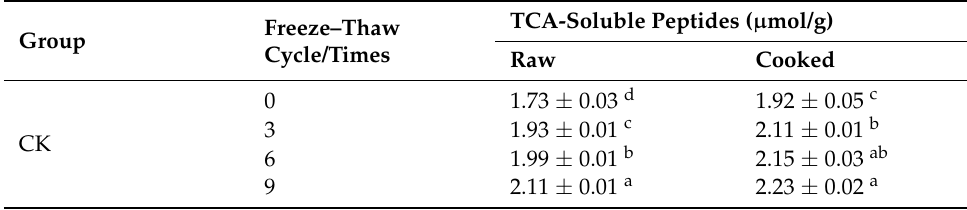
Table 1. Changes of TCA-soluble peptides contents in ground pork during freeze–thaw cycles and subsequent heating (100 ◦ C, 30